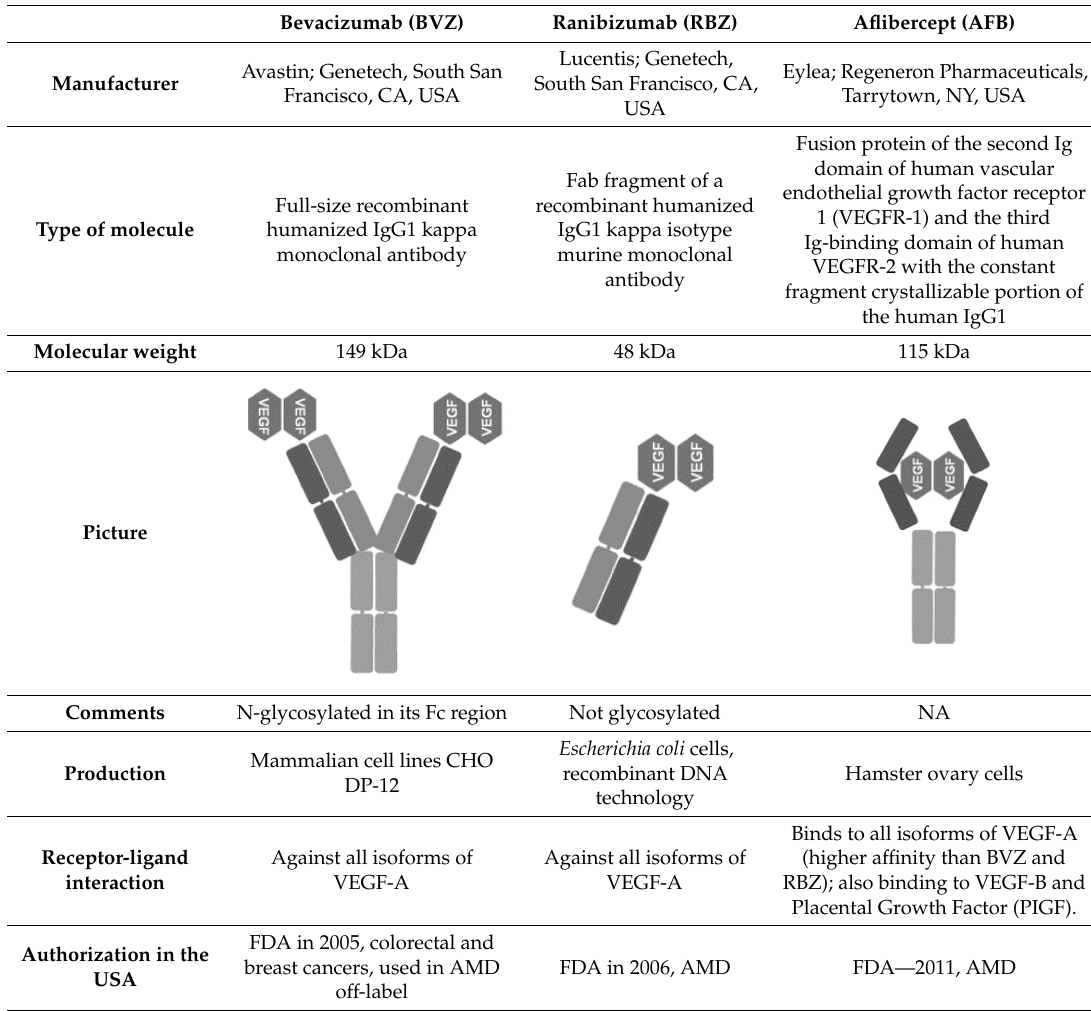
Table 1. Comparative characteristics of BVZ, RBZ and AFB, adapted from [3]. AMD: age-related macular degeneration.